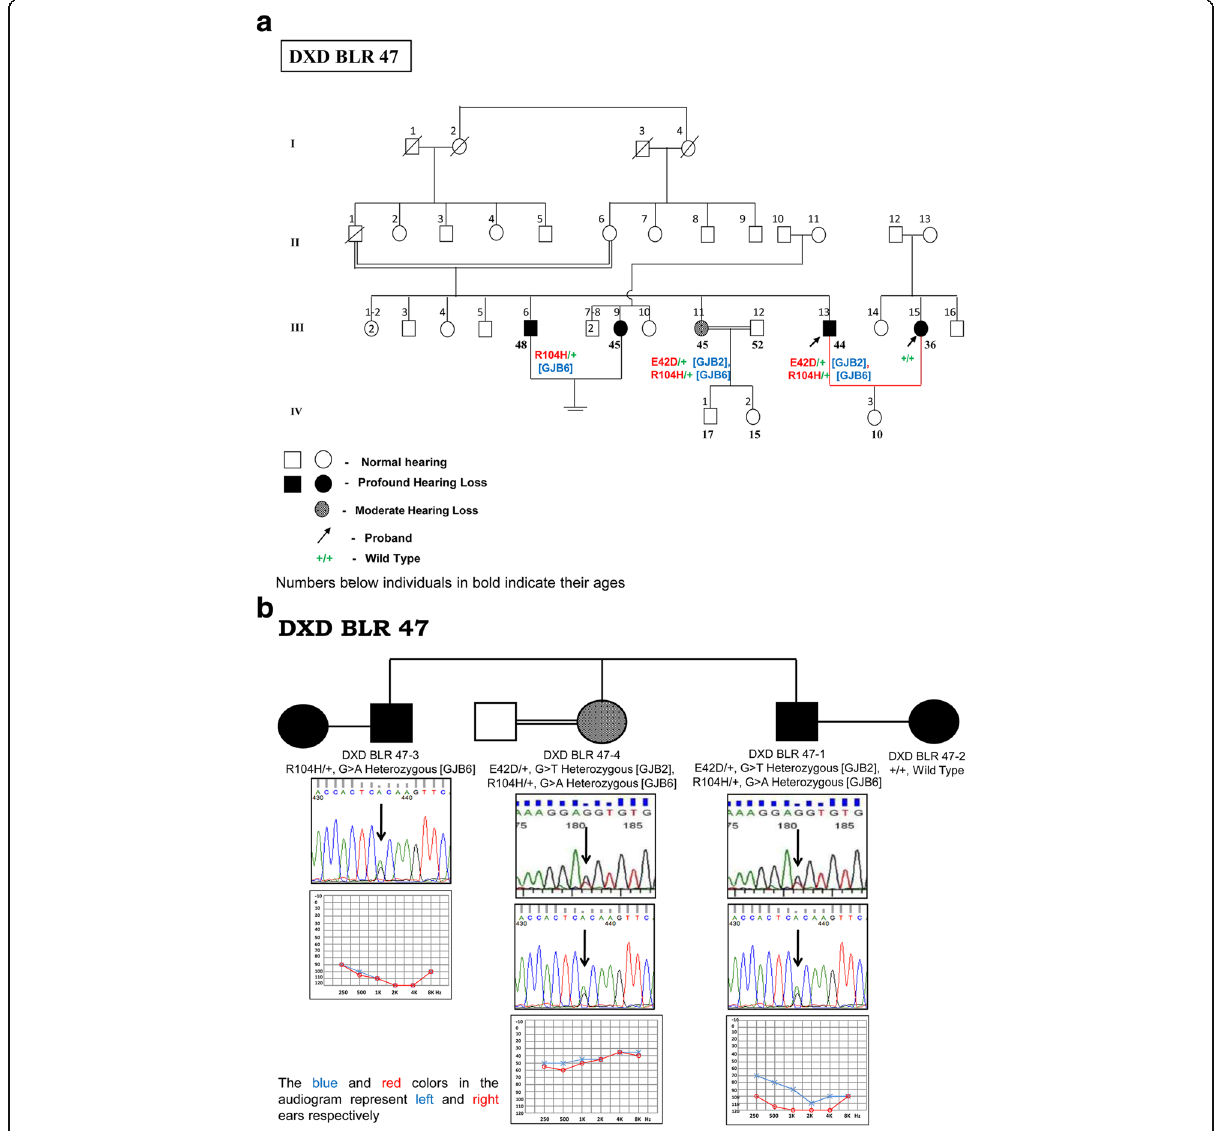
Fig. 3 a Pedigree of DXD BLR 47 family showing novel point mutations p.E42D& p.R104H in GJB2 & GJB6 genes, respectively (digenic). b Genotype-Phenotype correlation in DXD BLR 47 family with novel GJB2/GJB6